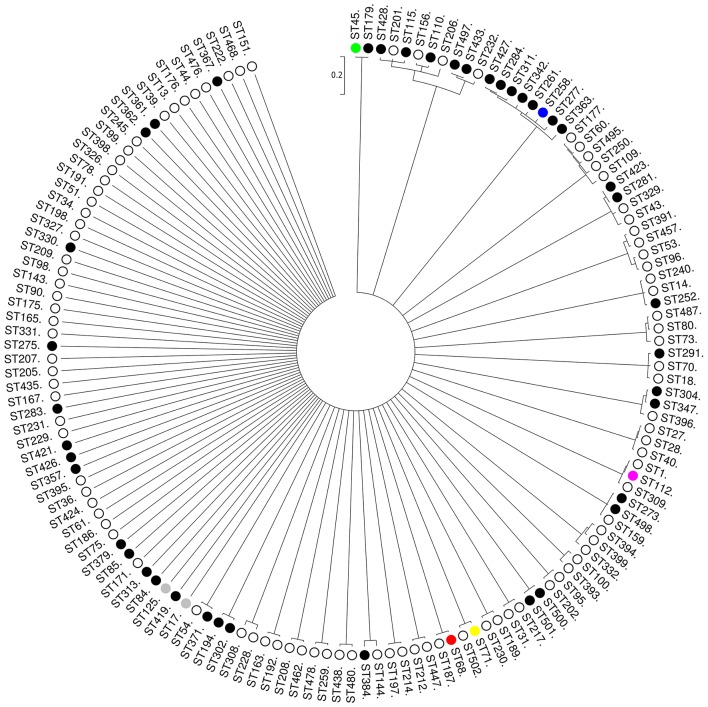
Unrooted consensus tree displaying the relationship between the 144 STs of the S. pseudintermedius sample (96 MSSP, 46 MRSP, and 2 MSSP/MRSP) at seven concatenated loci (2944 nucleotides in total). The 144 STs represent major eBURST group/subgroup founders (with more than three SLV links) and singletons with no double locus variant (DLV) links to eBURST-assigned CCs. The phylogenetic tree was based on all trees sampled after 2,000,000 iterations, from which half were discarded as burn-in. The dendogram was constructed from the combination of two ClonalFrame runs with a cut-off value of 0.5 as a majority rule consensus. Scale is in coalescent units. There were no well-supported nodes (i.e., with a Bayesian posterior probability > 0.90) for clusters with > 3 STs). The main MRSP clones are shown in different colors. MRSP, black; MSSP, white; both MRSP and MSSP, gray.